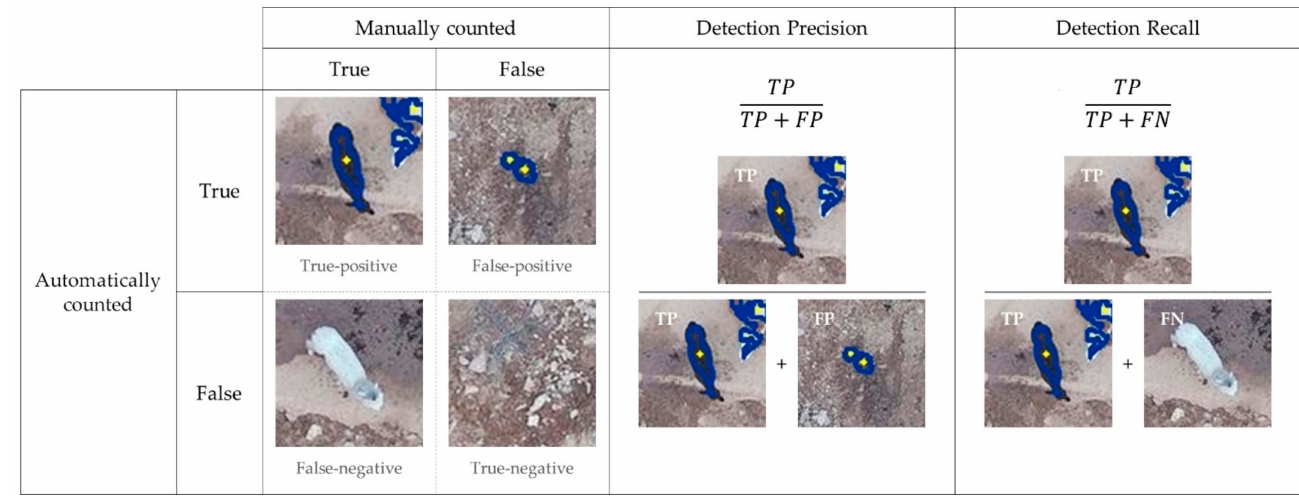
Figure 10. Calculation of detection precision and recall